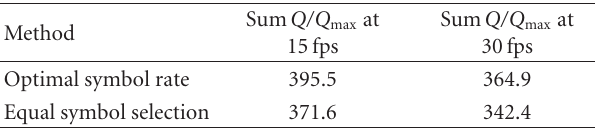
Figure 10: Allocation of symbols to videos with equal symbol rate allocation. Table 3: Comparison of quality at frame rates for multicast t = 15 and t = 30fps.